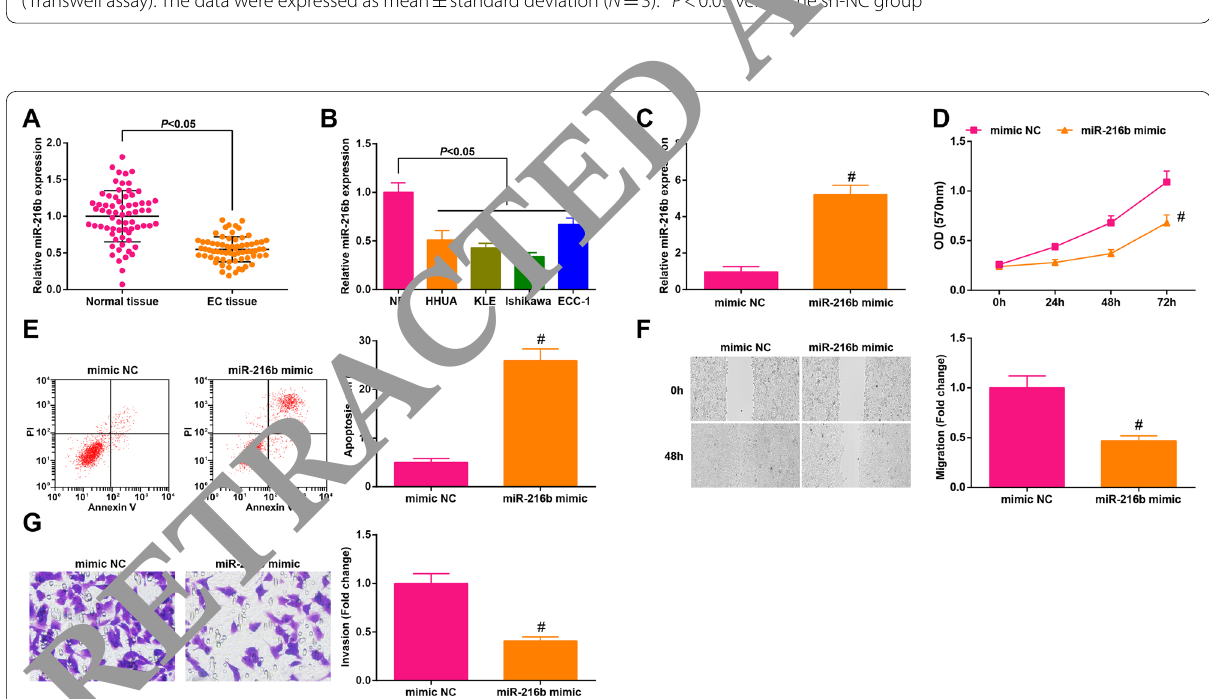
Fig. 3 Reduced miR-216b is tested in EC; Overexpressing miR-216b suppresses EC cell progression. a miR-216b expression was low in EC tissues versus normal tissues ( n 68) in RT-qPCR; b miR-216b expression was decreased in EC cell lines versus NE cells (RT-qPCR); c miR-216b expression = was elevated by miR-216b mimic in lshikawa cells (RT-qPCR); d Cell viability was suppressed by miR-216b mimic (MTT assay); e Cell apoptosis rate was induced by miR-216b mimic (flow cytometry); f Cell migration was limited by miR-216b mimic (scratch test); g Cell invasion was weakened by miR-216b mimic (Transwell assay). The data were expressed as mean standard deviation ( N 3). # P < 0.05 versus the mimic NC ± =